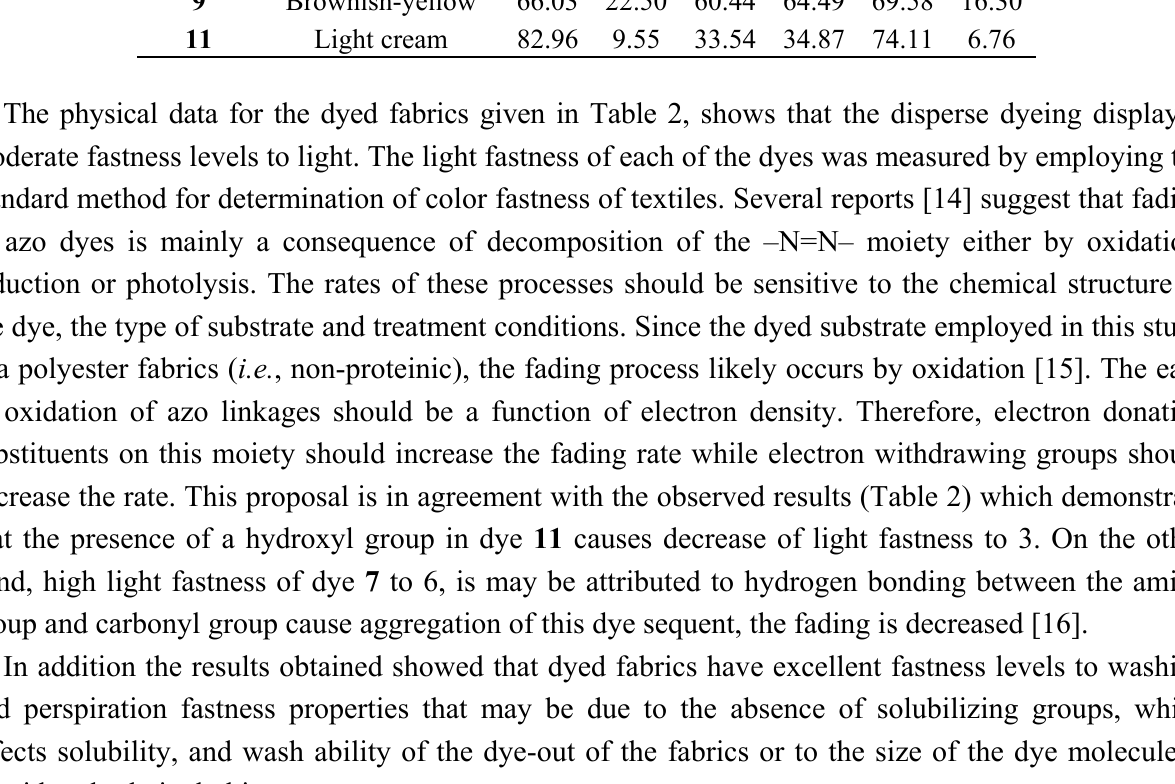
Table 2. Fastness properties of monoazo disperse dyes on polyester fabrics. Wash Dye No.